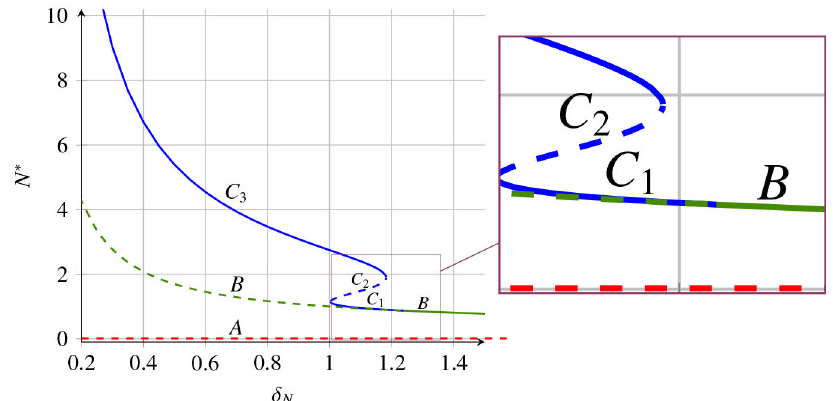
Fig 5. Bifurcation diagram showing coexistence of different tumour morphologies depending on cell death rate. Stability diagram for N * depending on parameter δ N of systems (13) – (15). Model parameters are as indicated in the caption of Fig 4. Different steady states of the system are drawn with different colours: A (red), B (green) and C i (blue). Solid line indicates stability while dashed one instability of the corresponding steady